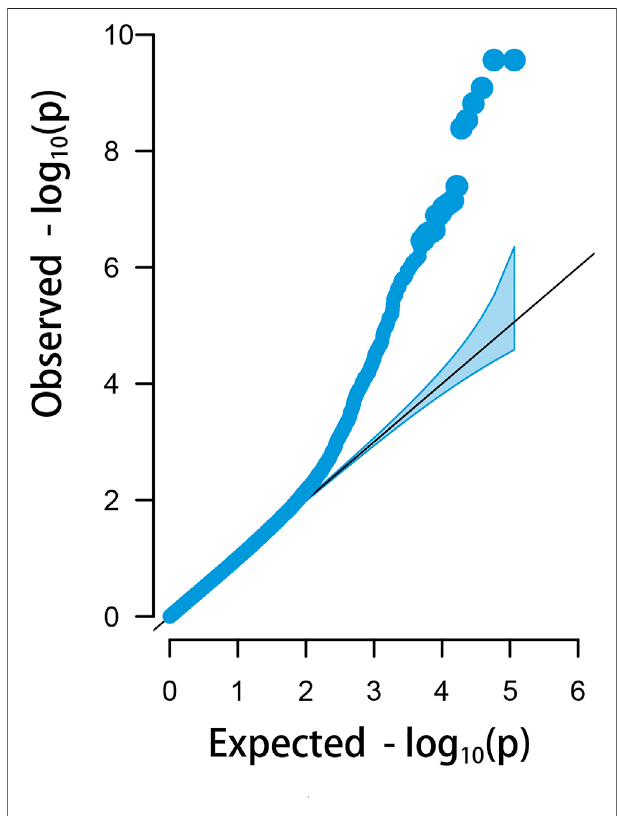
FIGURE 5 | Quantile – quantile plots of the logistic mixed model (LMM) analyzed for HVP traits in China yellow